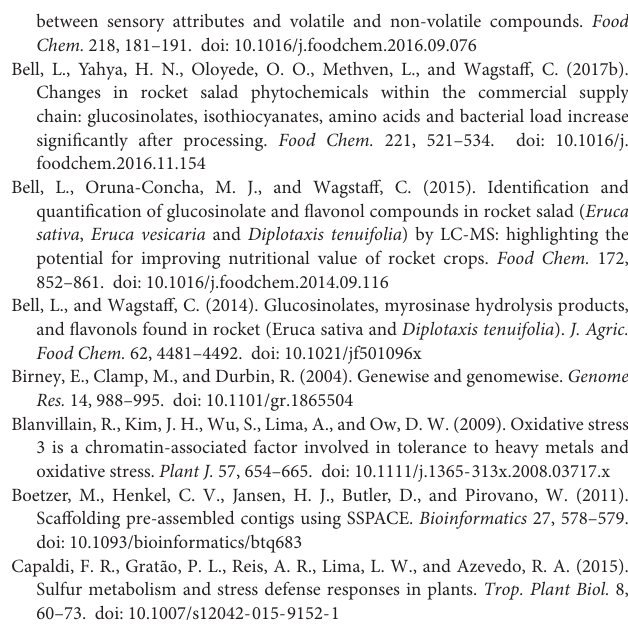
high degree of correlation ( r 2 = > 0.884) indicating robust reproducibility of gene expression between the individual plants tested at each respective sample point. Supplementary Figure 3 | qRT-PCR (green) vs. RNAseq (orange) gene expression of ten randomly selected glucosinolate biosynthesis and hydrolysis-related genes. Data are expressed as the normalized log2-fold change in expression relative to the reference gene ACT11 . ANOVA revealed no significant difference between the two data sets. EH , early harvest; H , harvest; SC , second harvest; PW , pre-wash; D0 , post-wash; and D7 , 7-day shelf life. Supplementary Table 1 | Genome sequencing pooled DNA sample quality control data for three Eruca sativa elite inbred lines. Supplementary Table 2 | RNAseq sample quality control data. Supplementary Table 3 | qRT-PCR primers and efficiencies. Supplementary Table 4 | Numbers of genes with homology or functional